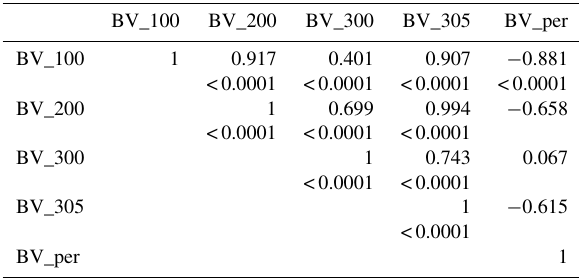
Table 2. Correlations between BV of lactation persistency and BV of test day milk production.